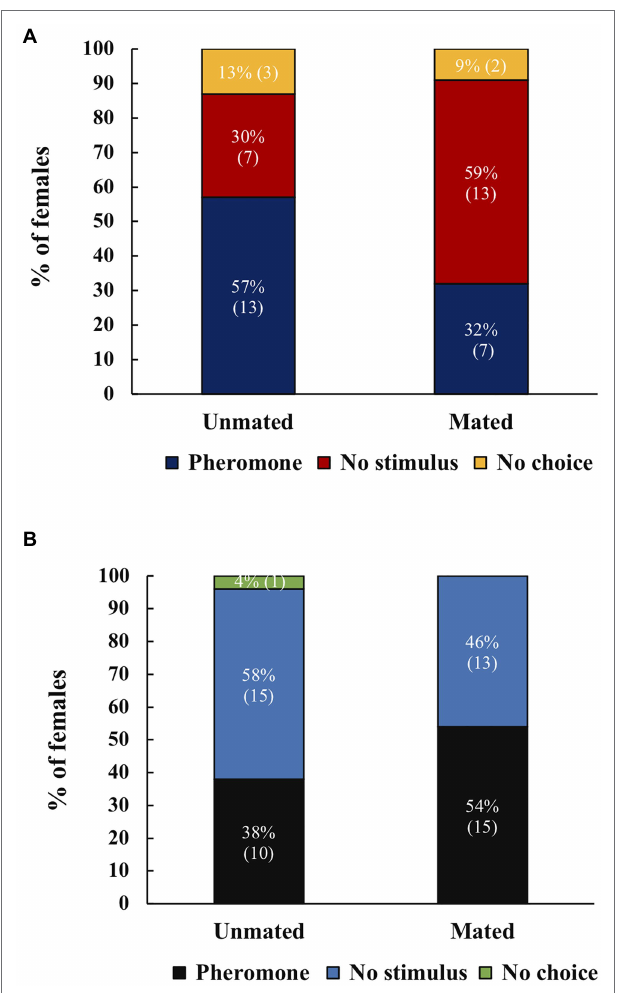
FIGURE 1 | (A) Response of unmated or mated Anastrepha ludens females to male sex pheromone or no stimulus, ( N = 23 for unmated, N = 22 for mated). (B) Response of unmated or mated Anastrepha obliqua females to male sex pheromone or no stimulus, ( N = 26 for unmated, N = 28 for mated). There were no significant differences. Numbers within parenthesis represent sample size.